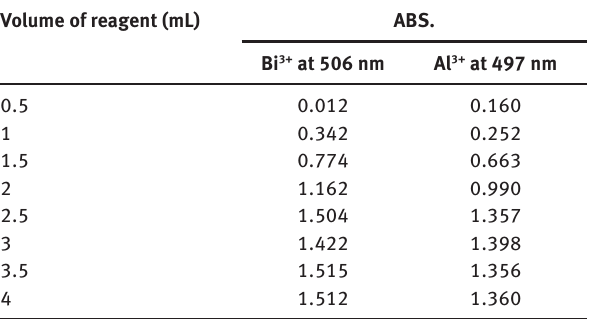
Table 5: The best volume of the reagent required to complete the reaction of Bi(III) and Al(III) with 4-APAP Volume of reagent